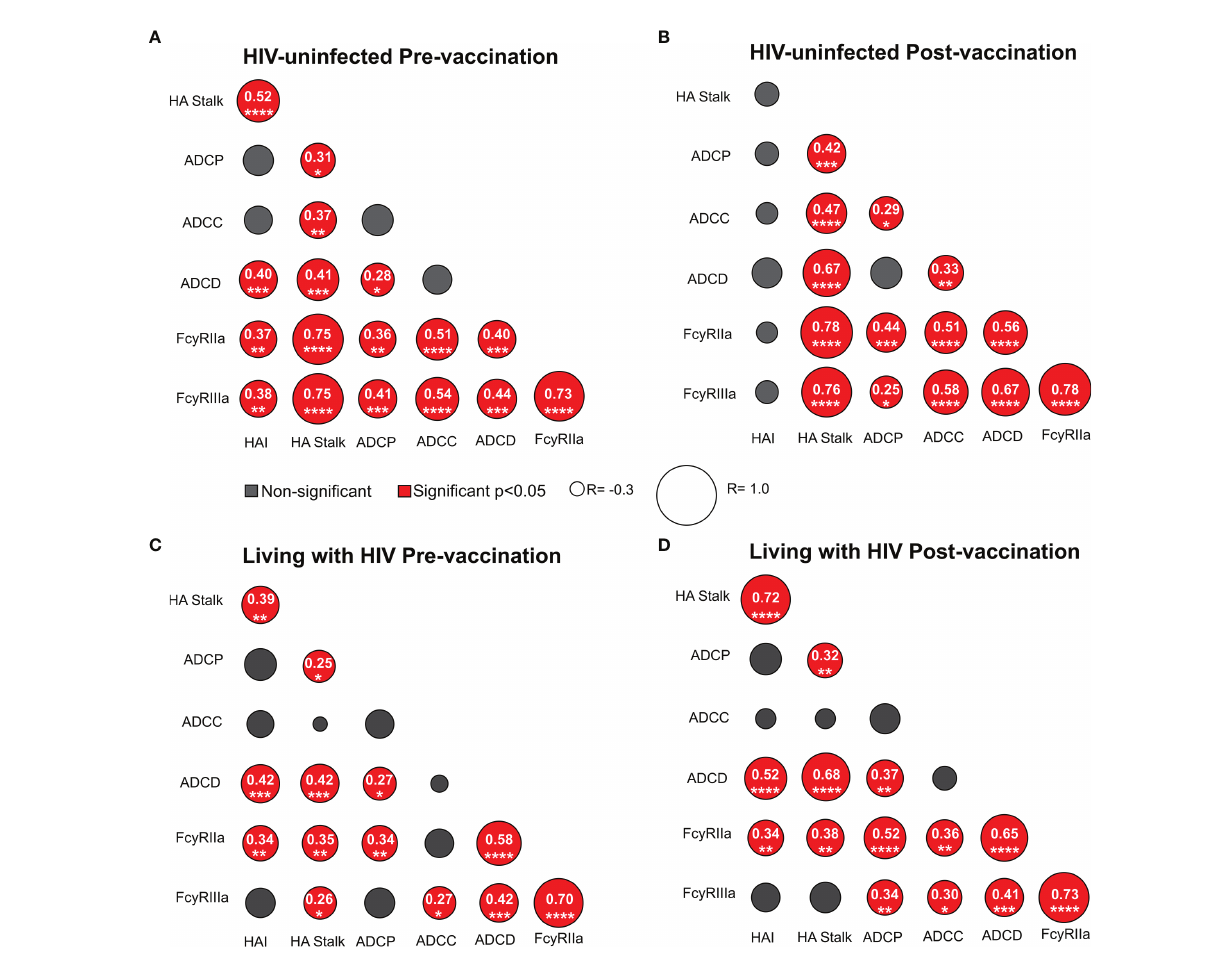
FIGURE 3 | Co-ordination between HAI titers, HA stalk antibodies and HA stalk-speci fi c Fc-mediated functions in response to vaccination. Spearman correlations of Fc effector function and titers in (A) HIV-uninfected pre-vaccination, (B) HIV-uninfected post-vaccination, (C) WLWH pre-vaccination and (D) WLWH post-vaccination groups. The asterisks indicate the following statistical signi fi cance, ****p < 0.0001; ***p < 0.001; **p < 0.01; *p < 0.05; ns,not signi fi cant. Signi fi cant correlations are displayed in red. Non-signi fi cant correlations are in grey. The size of the circle is proportional to the Spearman correlation coef fi cients -0.3 been the smallest and 1 been the largest, indicated inside of circles for correlations that were signi fi